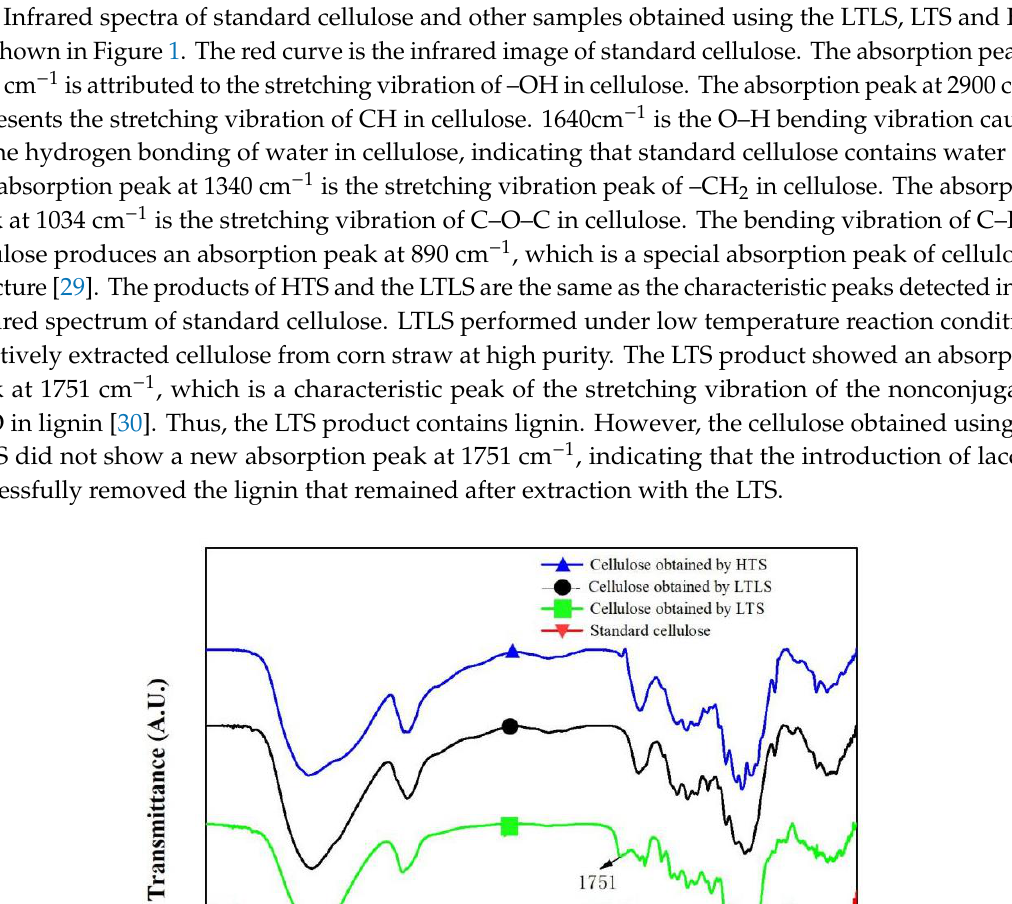
Table 1. Yield and color of products obtained using HTS, LTS and LTLS.